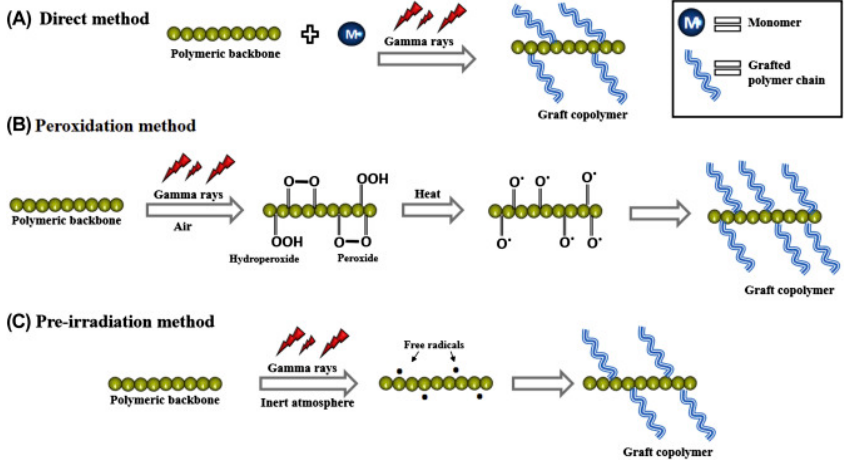
Figure 4. Schematic representation of the direct irradiation ( A ) and pre-irradiation methods ( B ) with the presence of oxygen, also known as the peroxidation method, and ( C ) without the presence of oxygen. Reprinted with permission from [79]. Copyright Elsevier, 2018.